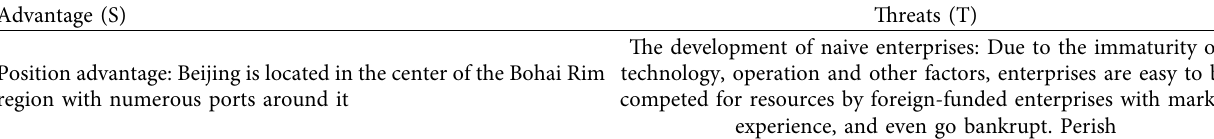
Table 1: SWOT analysis of RCEP’s impact on Beijing’s economic and trade